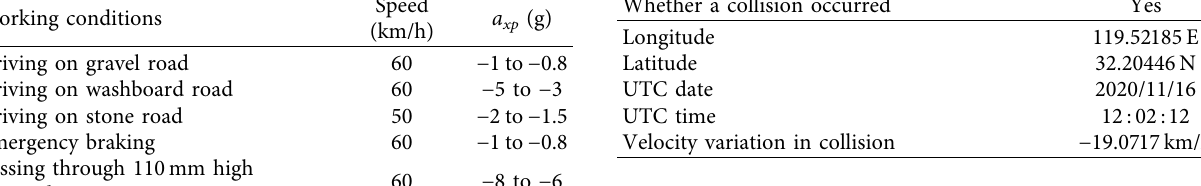
Table 21: Output of the ACN algorithm with VVCF.